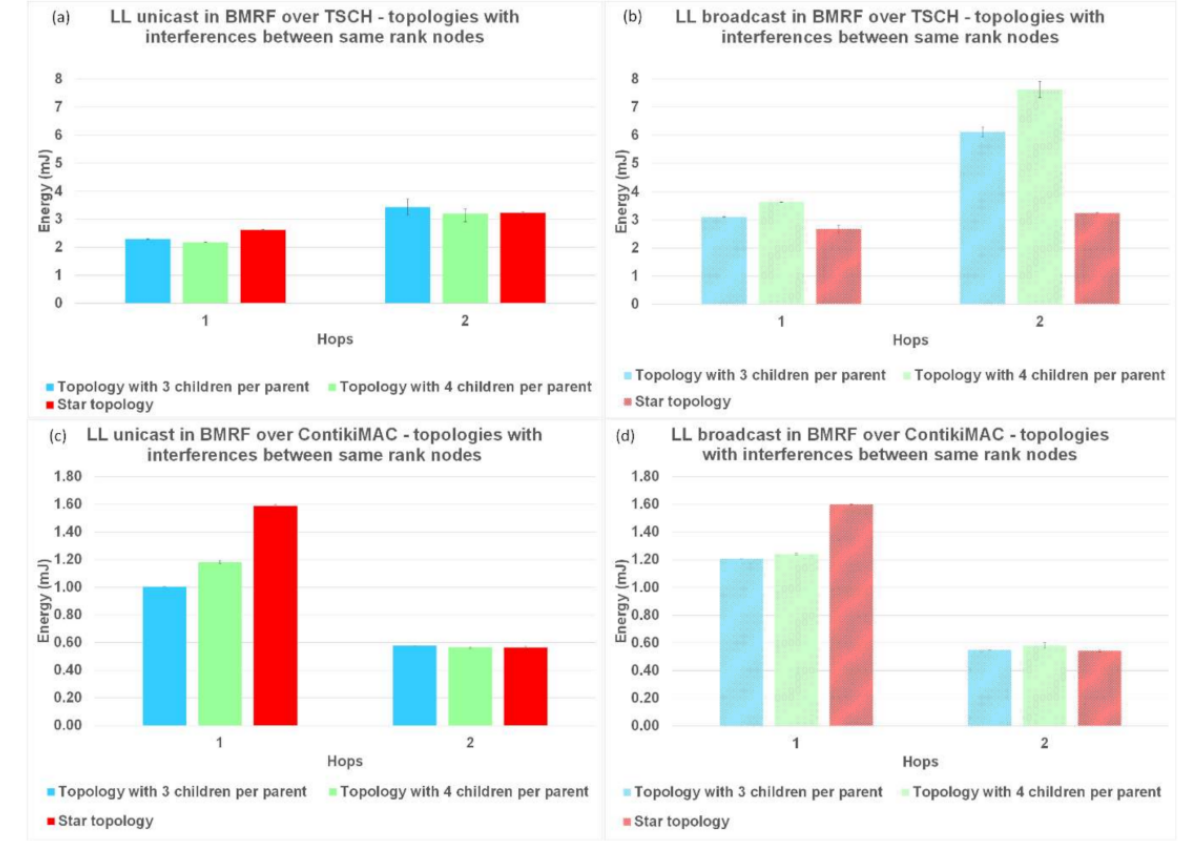
Figure 16. Energy comparison between LL unicast and LL broadcast and between ContikiMAC and TSCH on topologies with interference between same rank nodes. ( a ) Results for LL unicast in BMRF over TSCH. ( b ) Results for LL broadcast in BMRF over TSCH. ( c ) Results for LL unicast in BMRF over ContikiMAC. ( d ) Results for LL broadcast in BMRF over